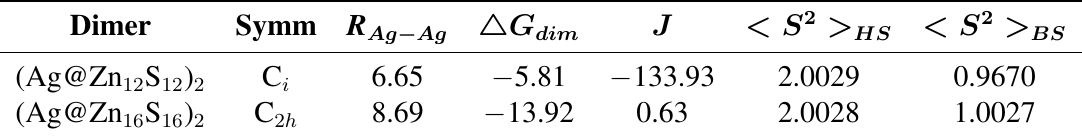
Table 4. Symmetry of the dimers and the distance between the two Ag atoms, R in ˚ A. The dimerization energies, (cid:52) G constant (cm − 1 ) and < S 2 > and broken symmetry states